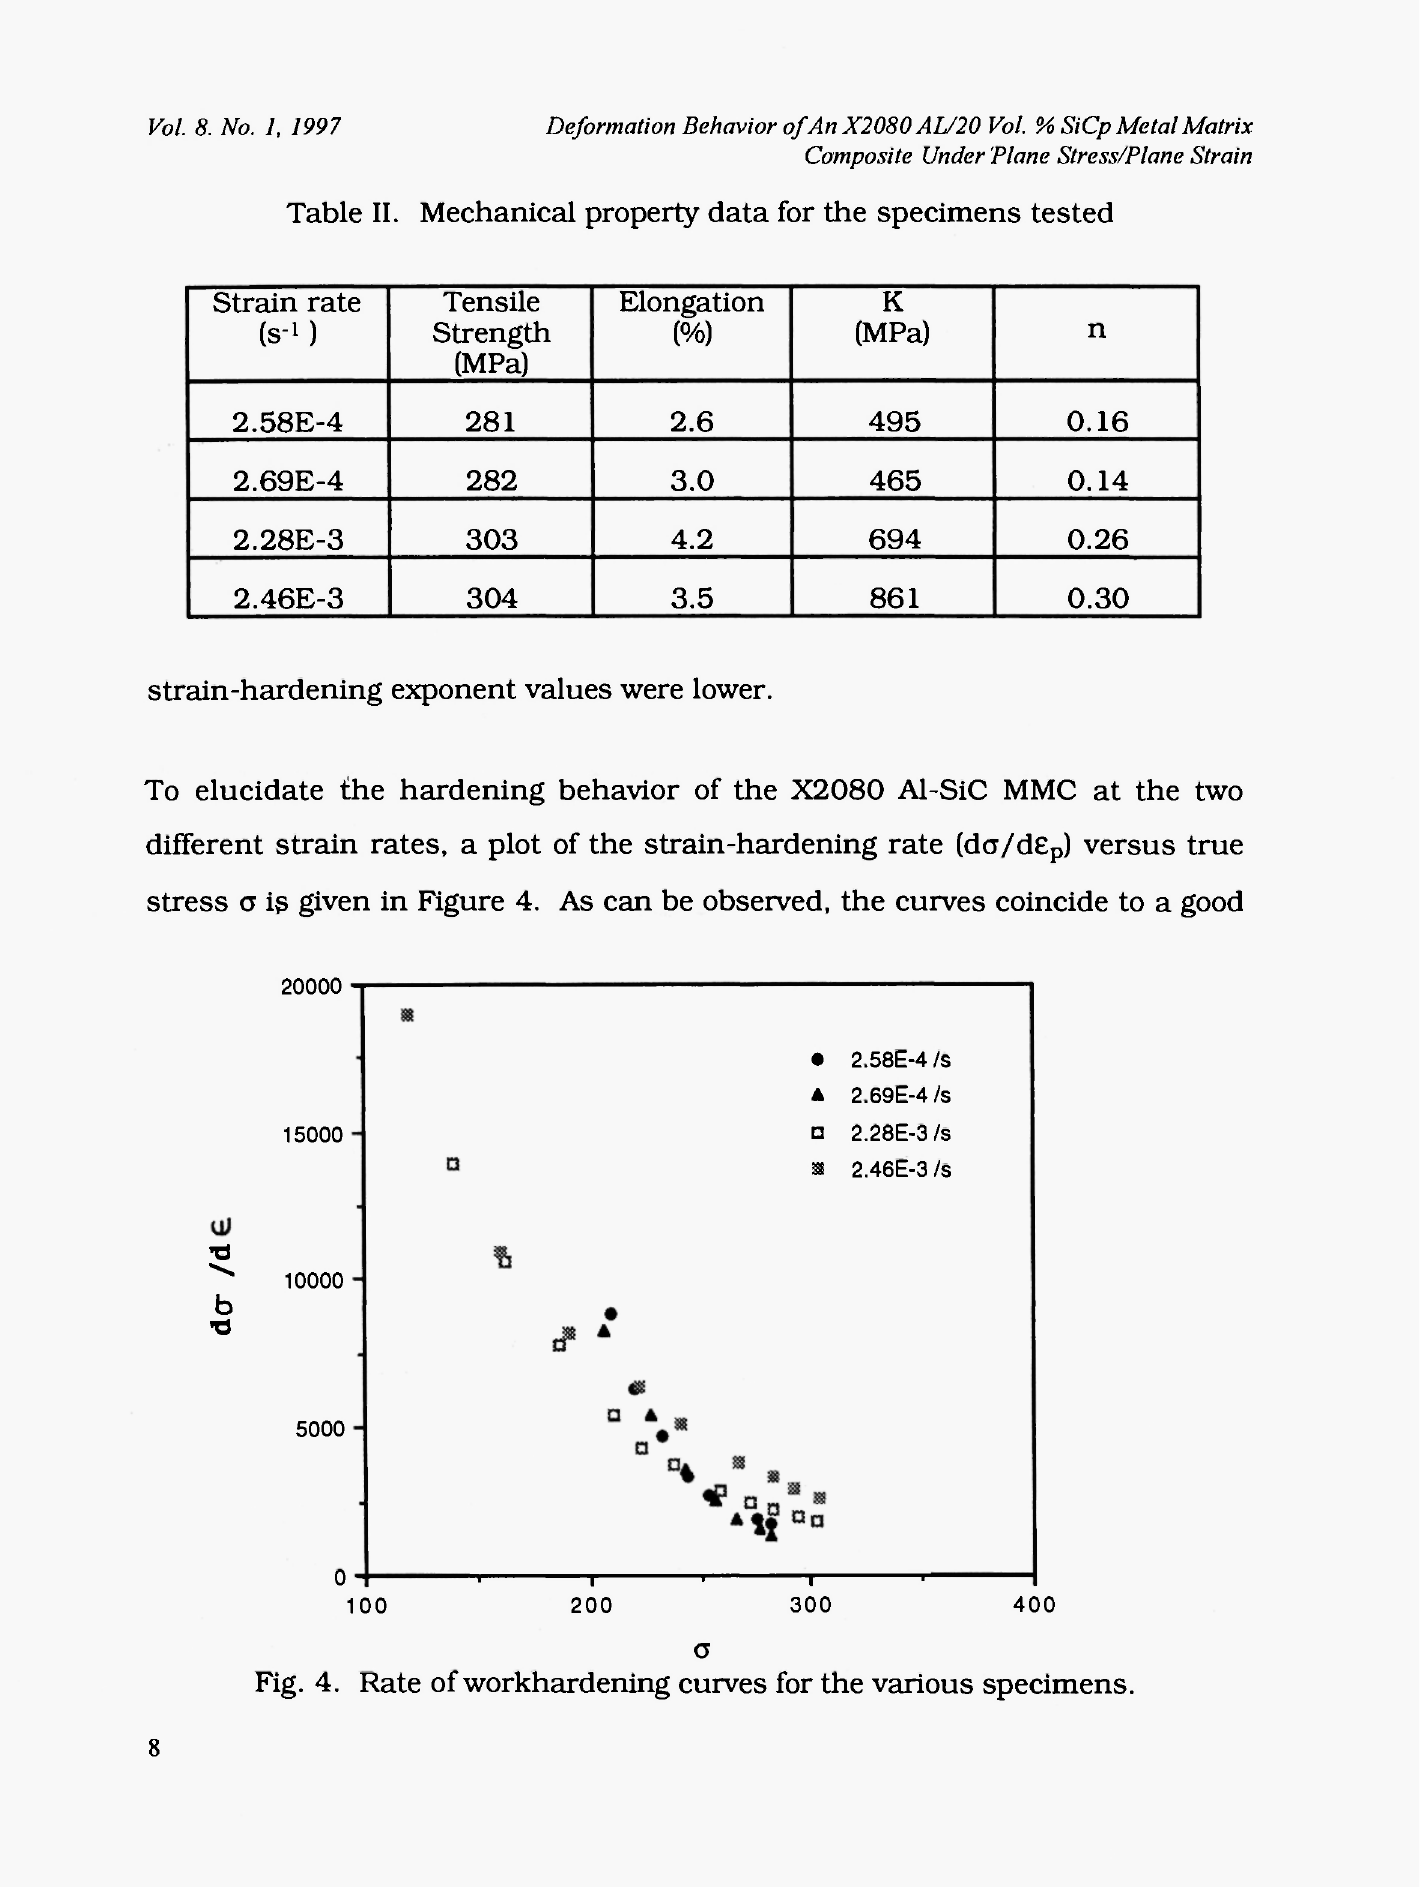
Fig. 4. Rate of workhardening curves for the various